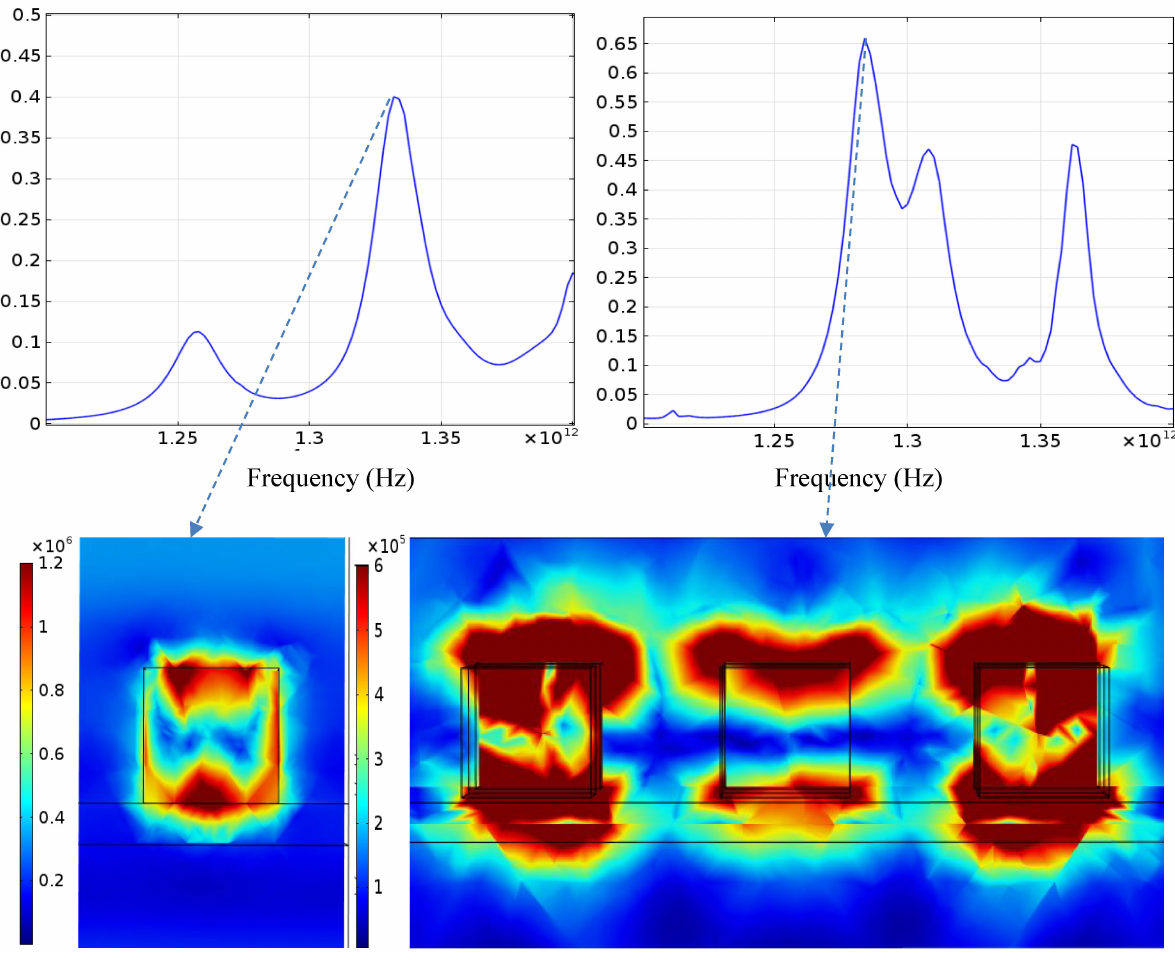
Figure 7. ( Left ) absorption for a single CNT plot (top) and electric field pattern at frequency 1.332 THz, ( Right ) absorption for a 3 × 3 array of CNT plots (top) and electric field pattern at frequency 1.284